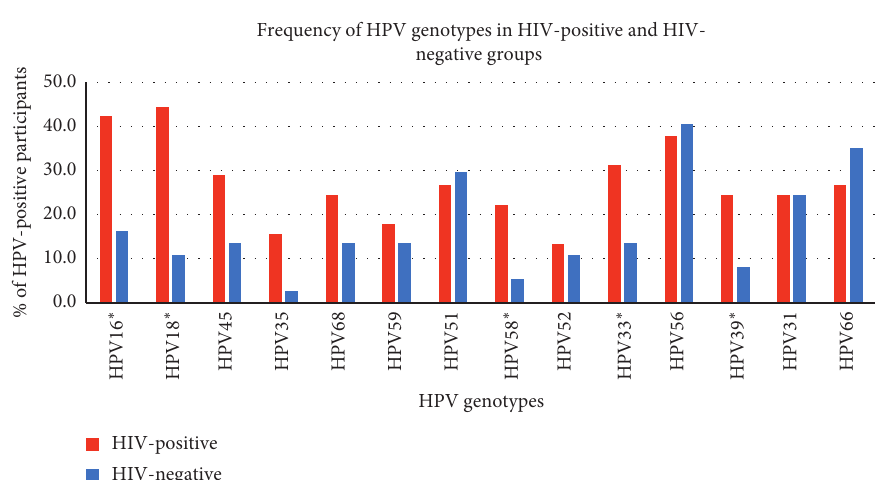
Figure 1: HPV genotypes in HIV-positive and HIV-negative MSM ( N � 120). Asterisk marks the significant correlation of HPV genotype and HIV